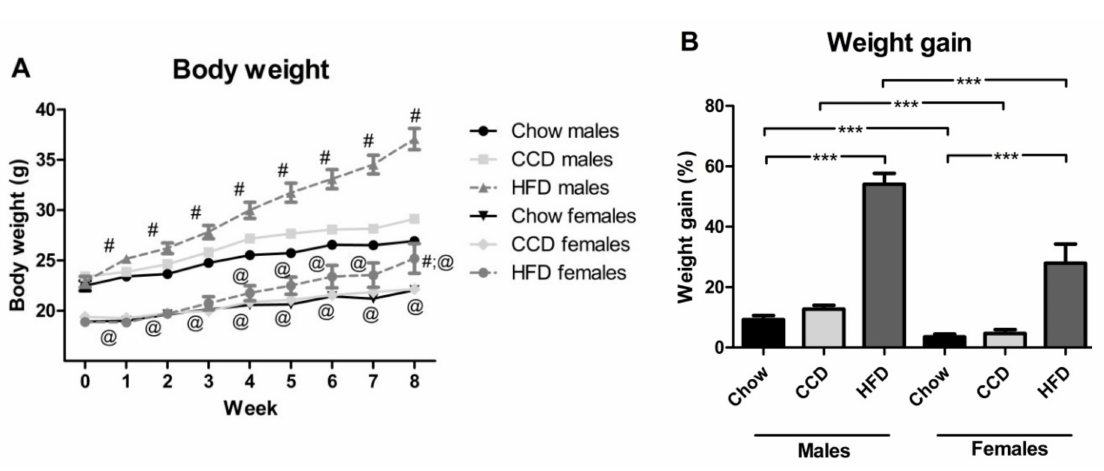
Figure 1. Body weight progression ( A ) and accumulated weight gain in percentage ( B ) in male and female mice exposed to a high-fat diet (HFD), commercial control diet (CCD) or a chow diet for 8 weeks. *** p < 0.001; #: di ff erent from chow in the same sex, @: di ff erent between sexes on the same diet. n =